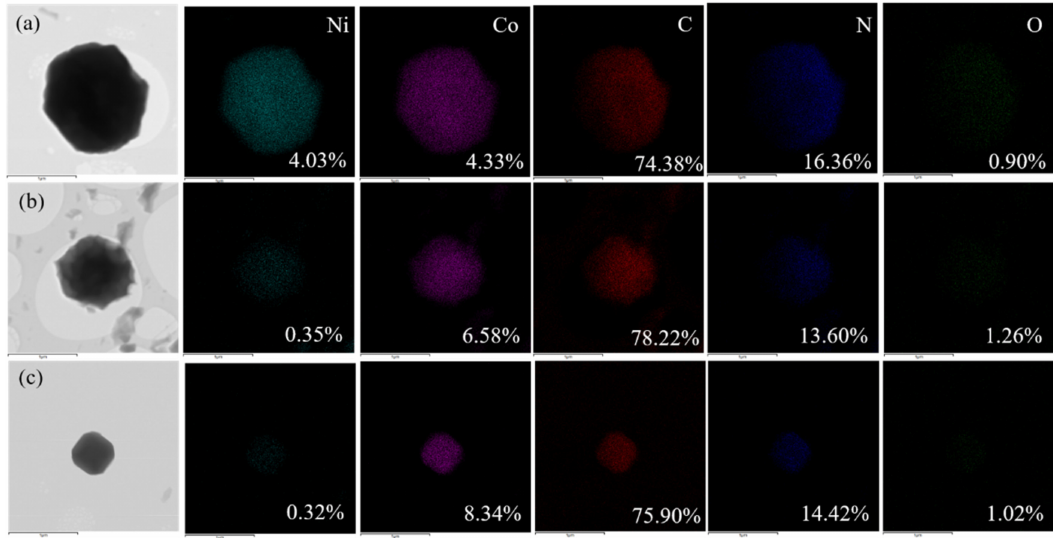
Figure 3. The TEM images and different elemental mappings of Ni x Co y -ZIFs crystals: ( a ) Ni 1 Co 1 - ZIFs; ( b ) Ni 1 Co 2 -ZIFs; ( c ) Ni 1 Co 4